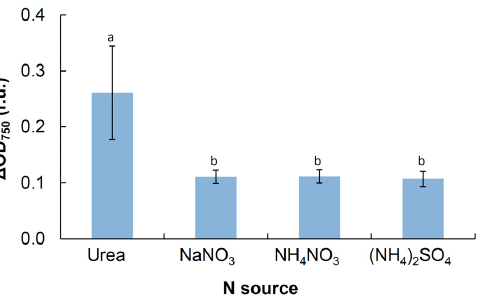
Figure 8. Growth of Neochlorella semenenkoi IPPAS C-1210 in the concentration matrix of NaHCO 3 and NaCl. One representative experiment out of two is shown.